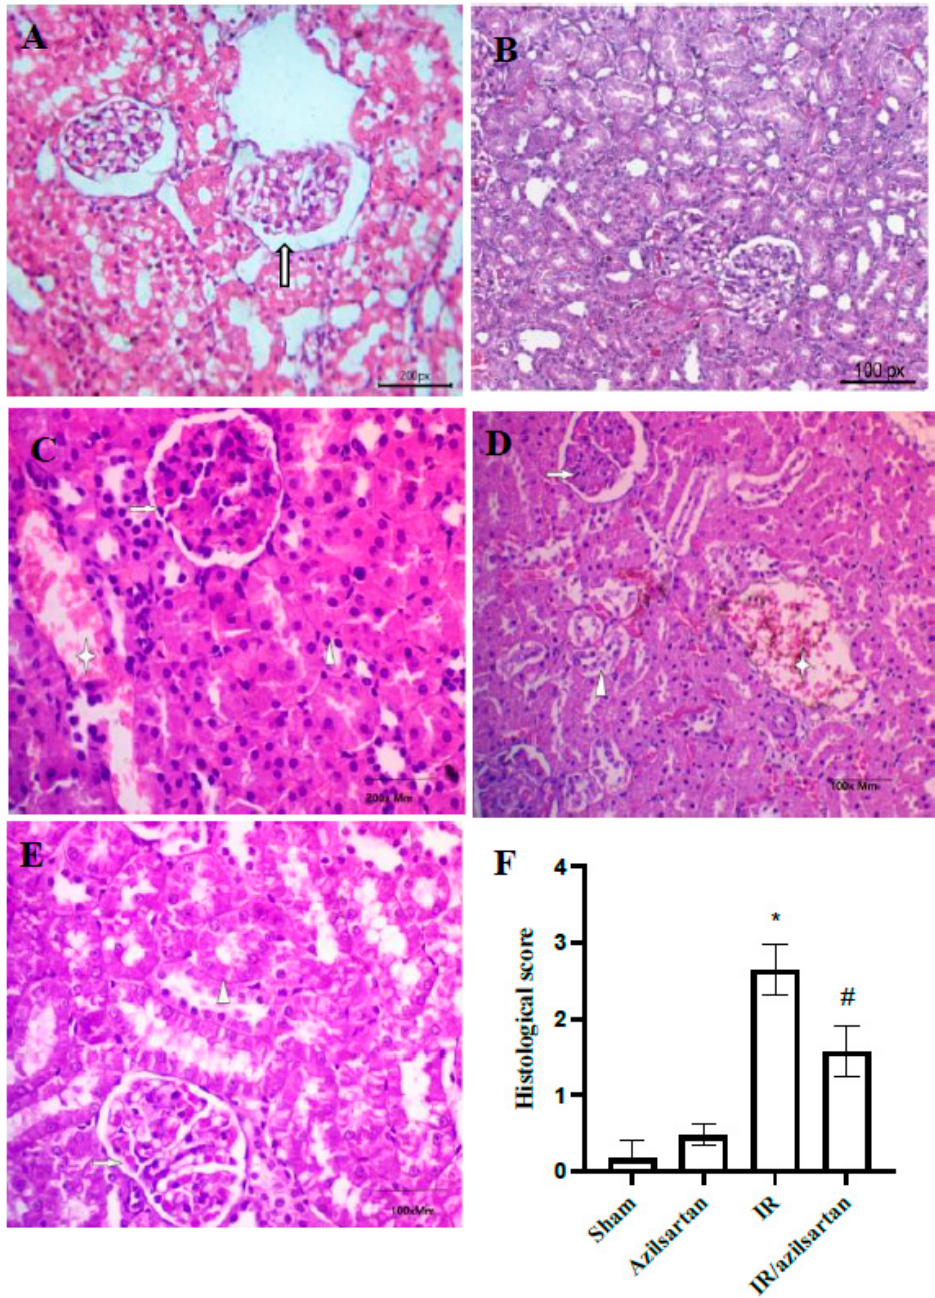
Figure 5. Representative photomicrographs of rat kidney tissues of different groups. Hematoxylin- eosin was used to stain kidney tissues. ( A ) The sham group (magnification; × 200), ( B ) the azilsartan- treated group (magnification; × 100), ( C , D ) the IR group (magnification; × 200 & × 100, respectively), and ( E ) the IR/azilsartan-treated group (magnification; × 100). ( F ) Histological score of kidney damage. Bars represent mean ± SD. Followed by post hoc Dunnett test, significant difference was analyzed by one-way ANOVA test, where * p < 0.001, compared to the sham group, and # p < 0.01, compared to the IR group. SD; standard deviation, IR; ischemia